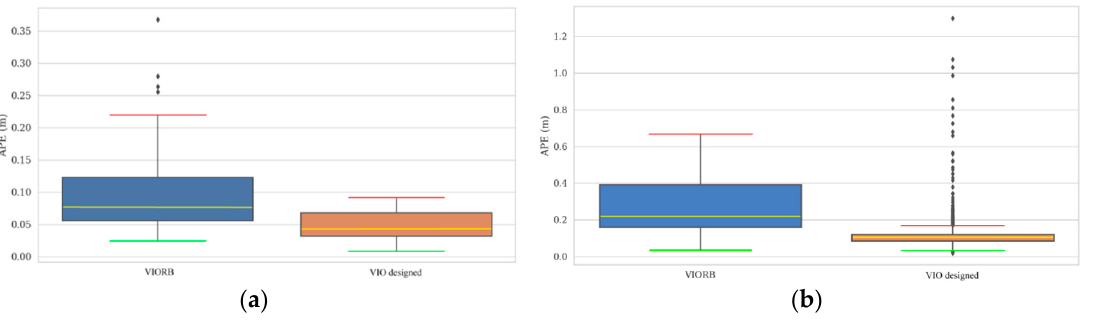
Figure 10. Absolute positioning error distribution, ( a ) V1_01_easy sequence; ( b ) MH_04_difficult sequence. Table 3. The comparative absolute positioning errors in the European Robotics Challenge (EUROC) datasets.